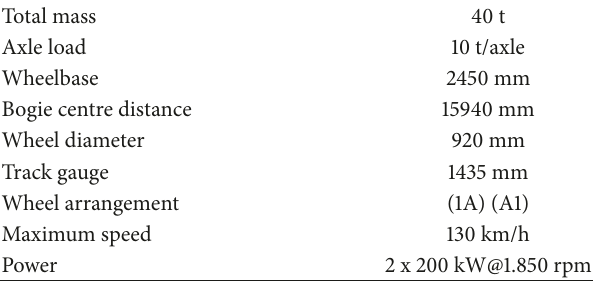
Table 2: Technical data of the single unit motor coach